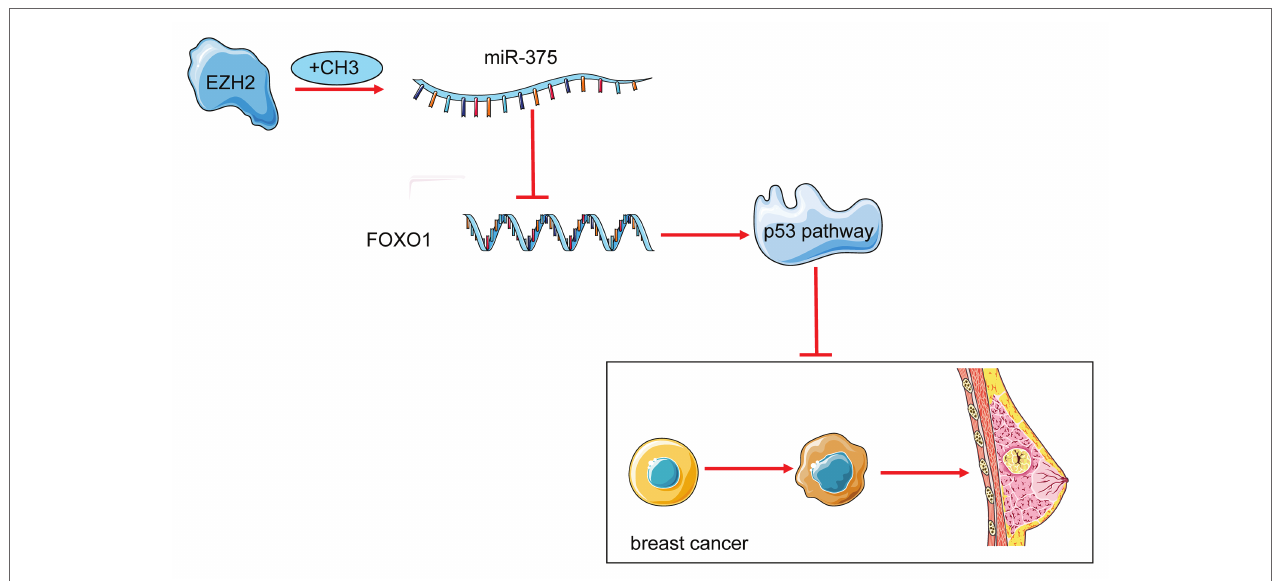
FIGURE 8 | A diagram for molecular mechanism. miR-375 is an important oncogene triggering BC progression. EZH2 increases methylation of STAT3 and enhances miR-375 transcription activity. Upregulation of miR-375 reduces FOXO1 expression and inactivates the p53 signaling pathway to suppress BC